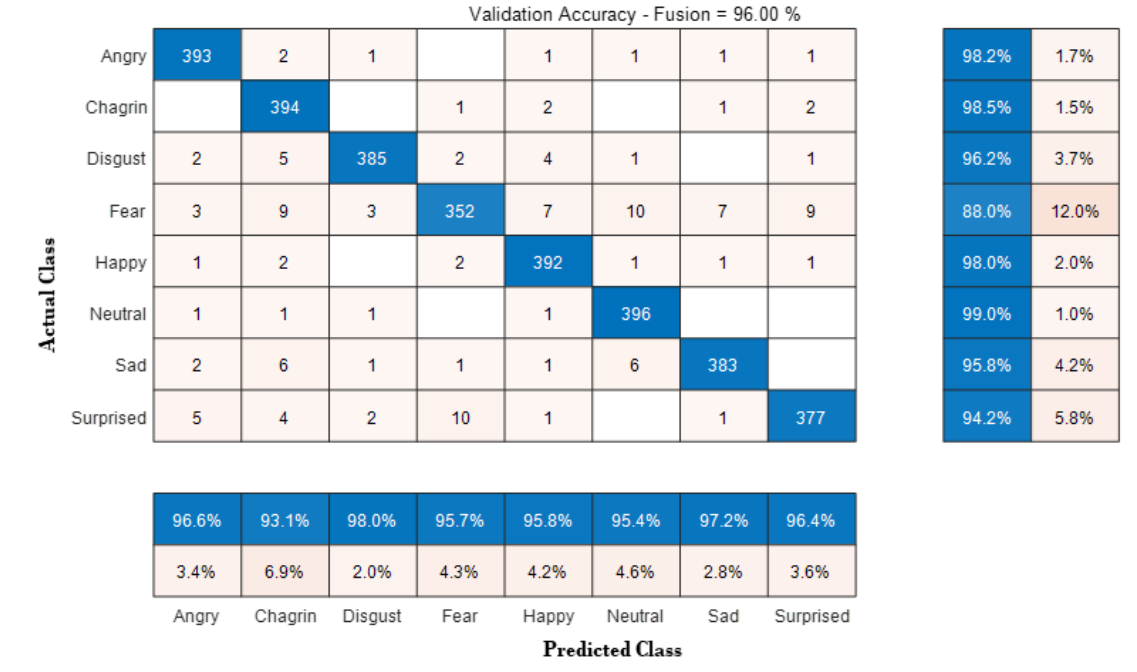
Figure 11. Confusion matrix of Bi-LSTM and CNN two-stream-based SER model.